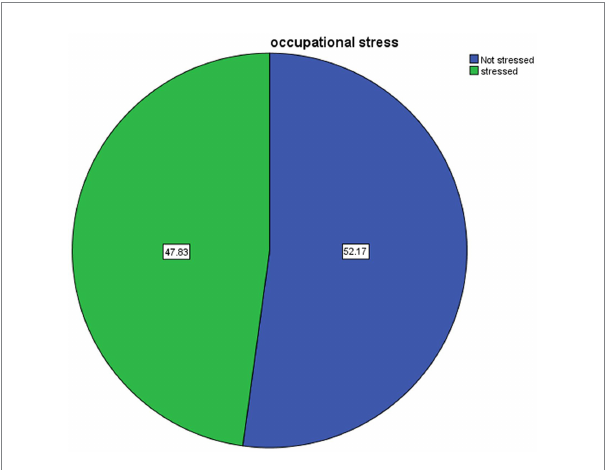
FIGURE 1 Prevalence of occupational stress among nurses working at Addis Ababa public hospitals, Ethiopia, 2022.